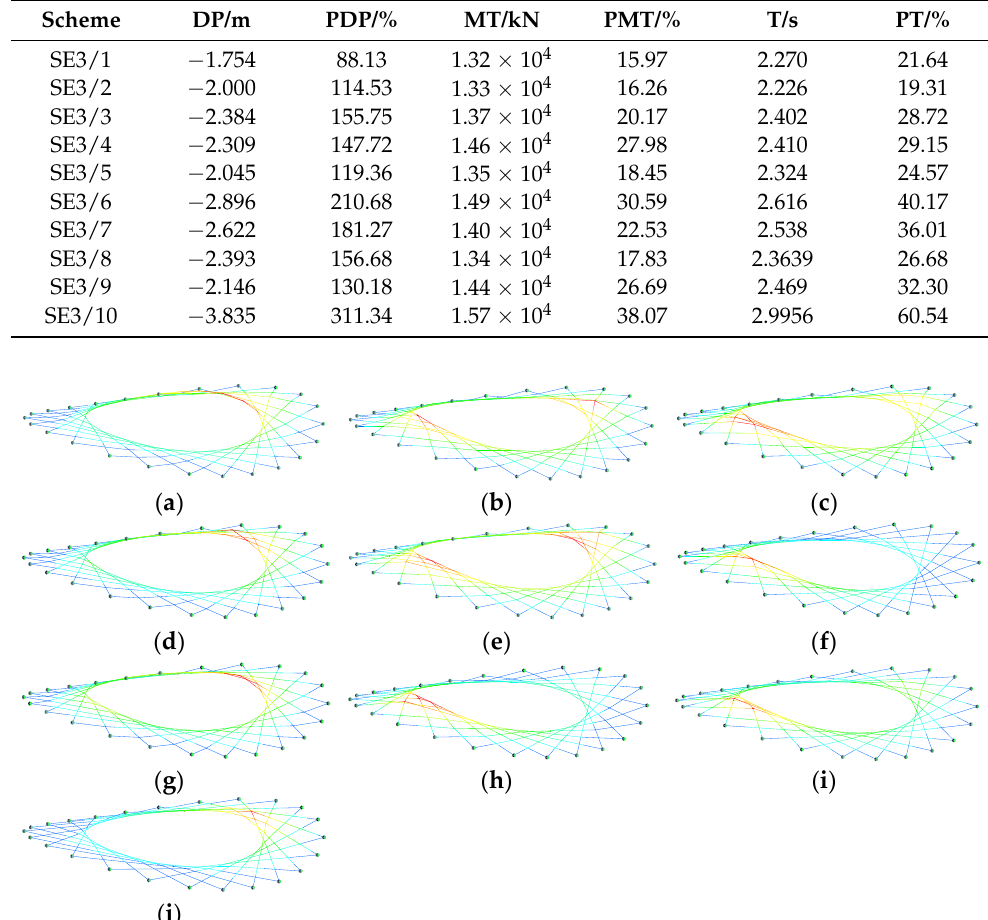
Figure 10. Vibration modes of schemes deleting three virtual rings. ( a ) SE3/1; ( b ) SE3/2; ( c ) SE3/3; ( d ) SE3/4; ( e ) SE3/5; ( f ) SE3/6; ( g ) SE3/7; ( h ) SE3/8; ( i ) SE3/9; ( j )